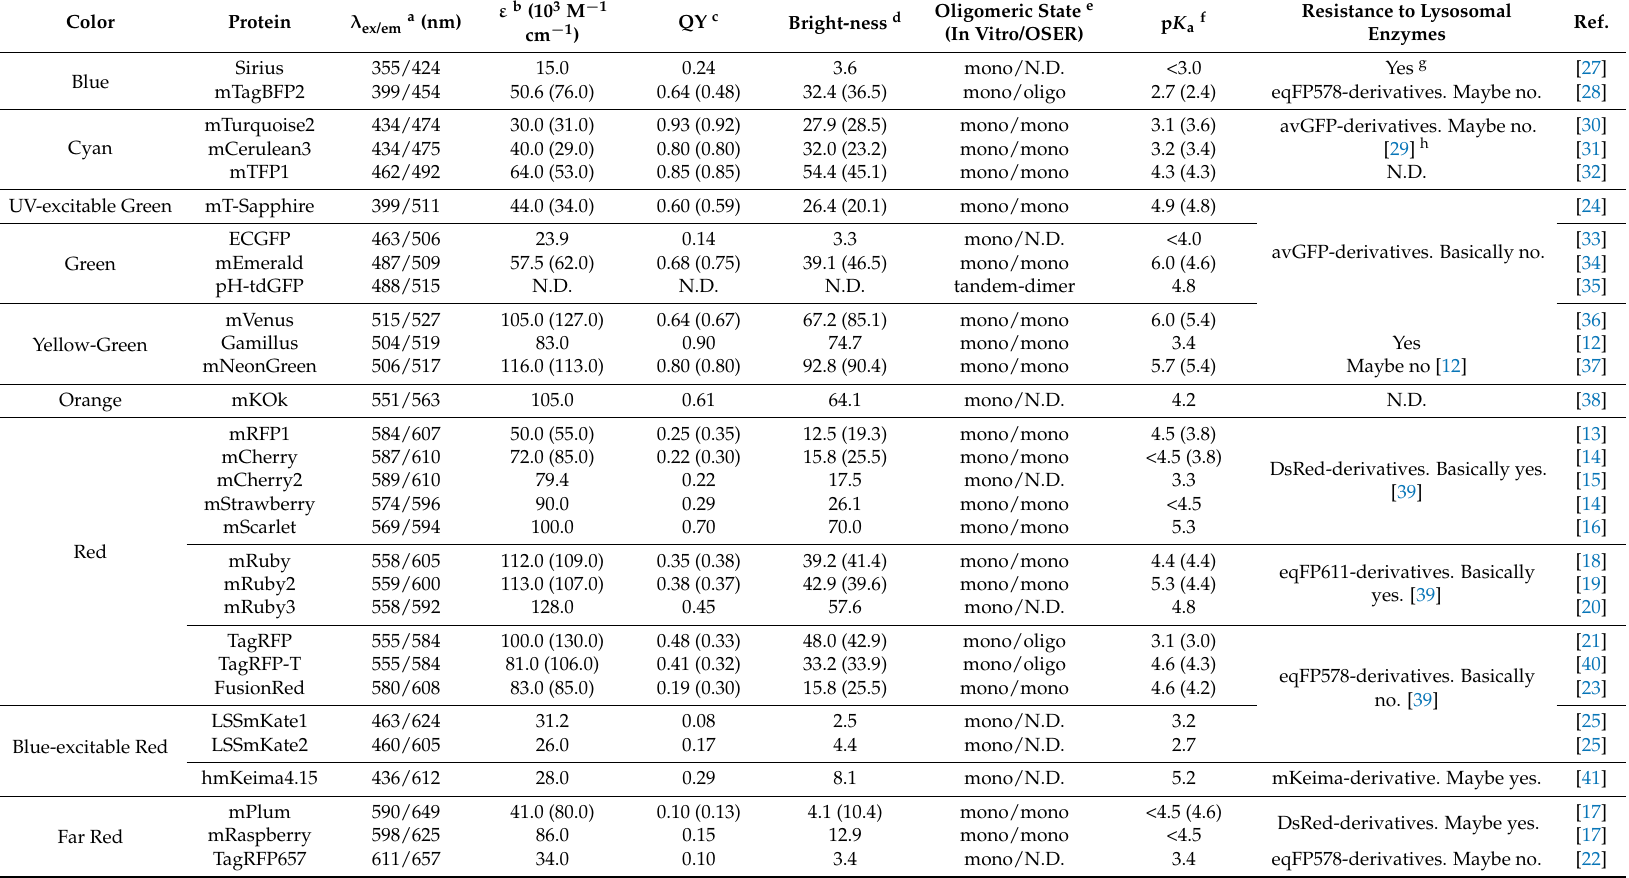
Table 1. Optical property of acid-tolerant GFP-like